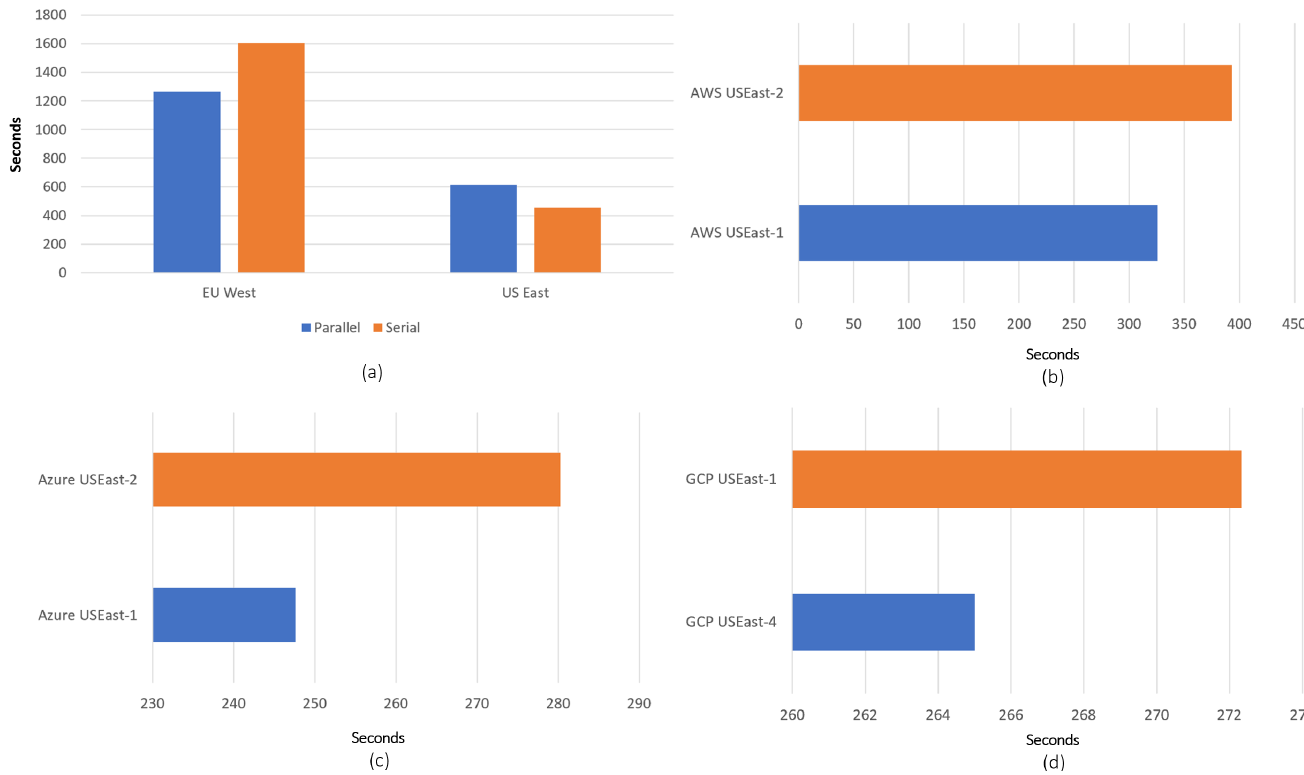
Figure 7. The results of performance experiments: ( a ) Parallel vs. serial execution using the region suggested by our approach for AWS; ( b – d ) region pair comparisons in parallel execution for all providers using region suggested by our approach and best guess